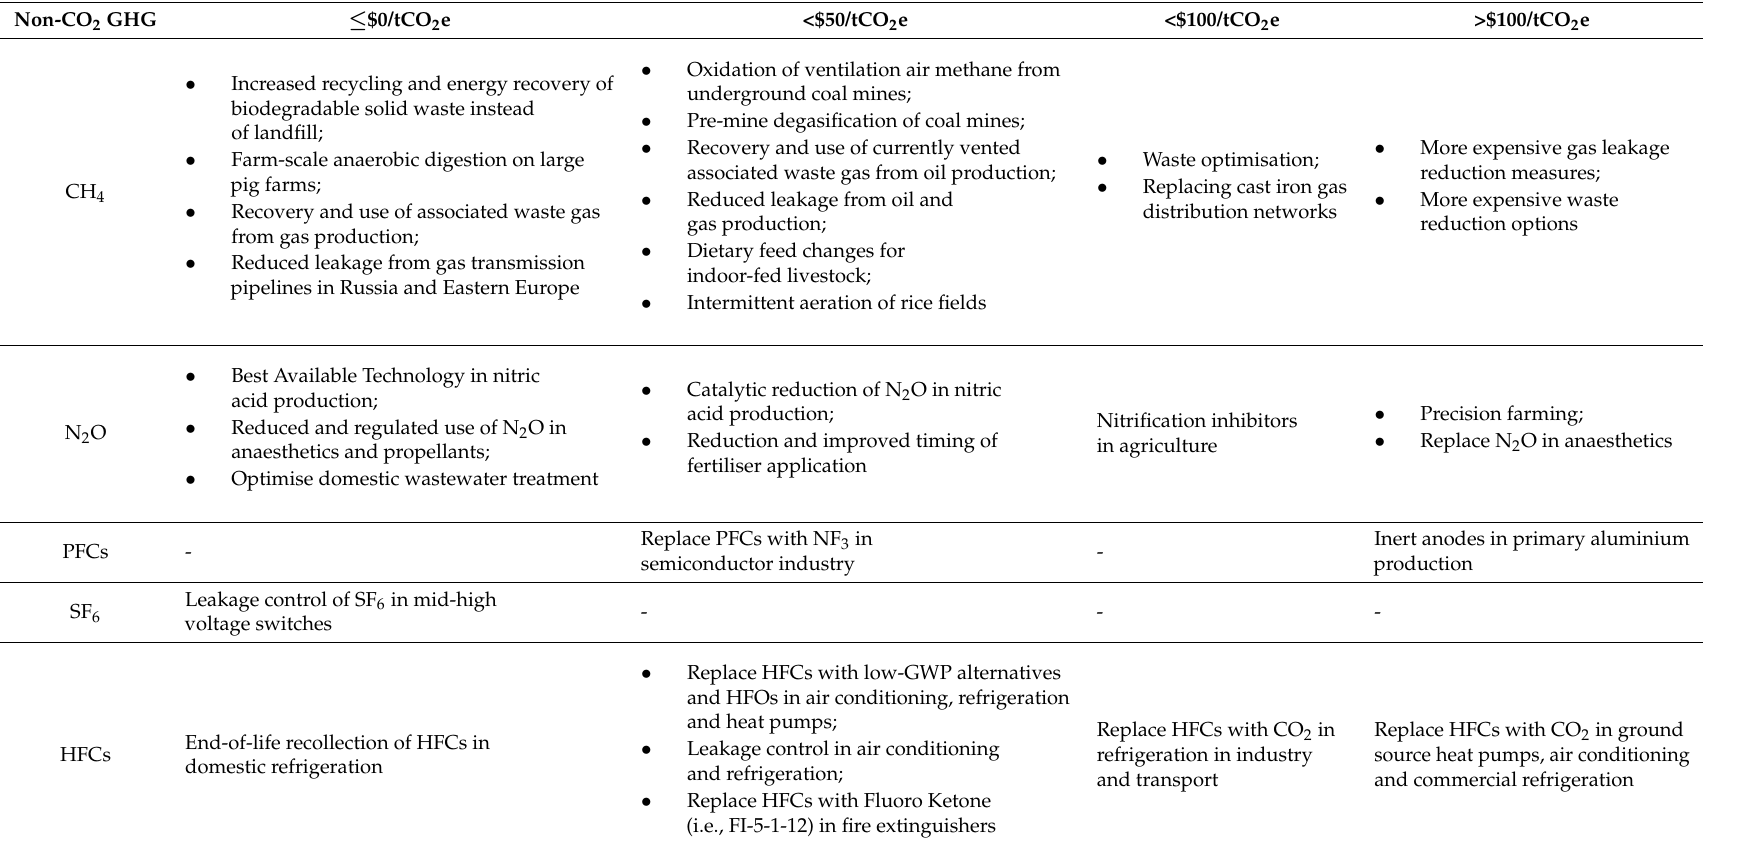
Table 2. Major non-CO 2 GHG mitigation measures in different cost